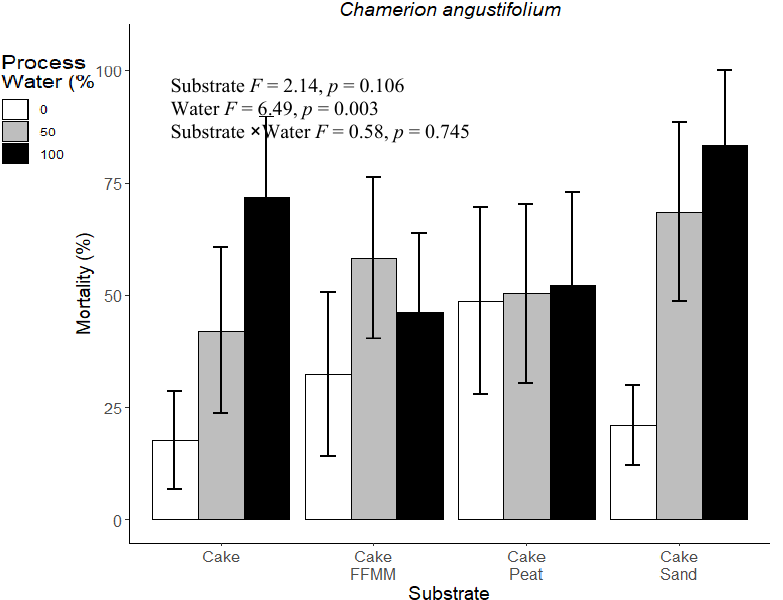
Figure 2. Mortality (mean and standard error) for Chamerion angustifolium under four soil amendments and three watering treatments.